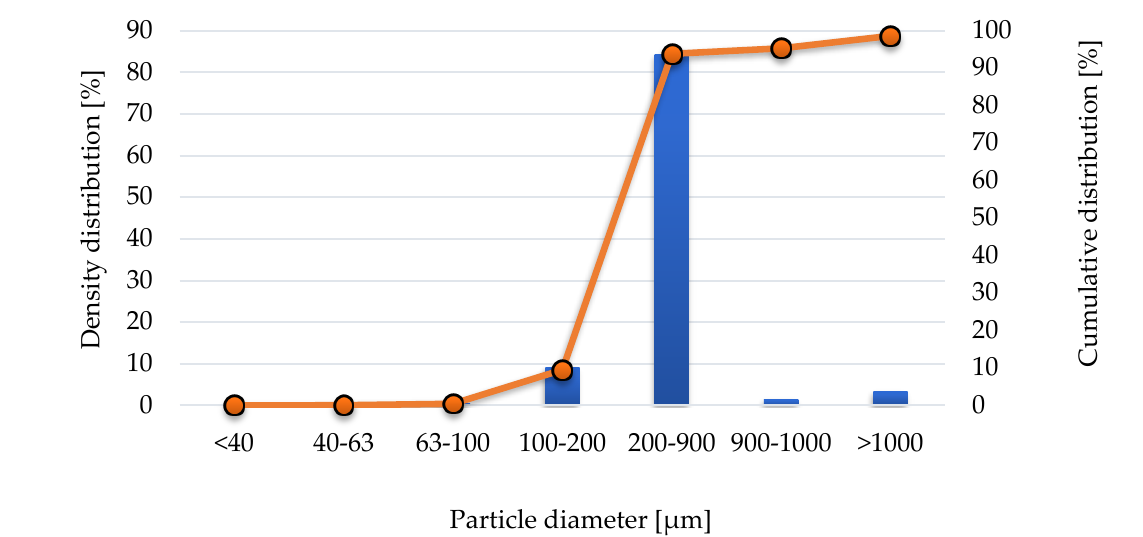
Figure 1. The diameter and distribution of sand particles (Świętochłowice, Poland).